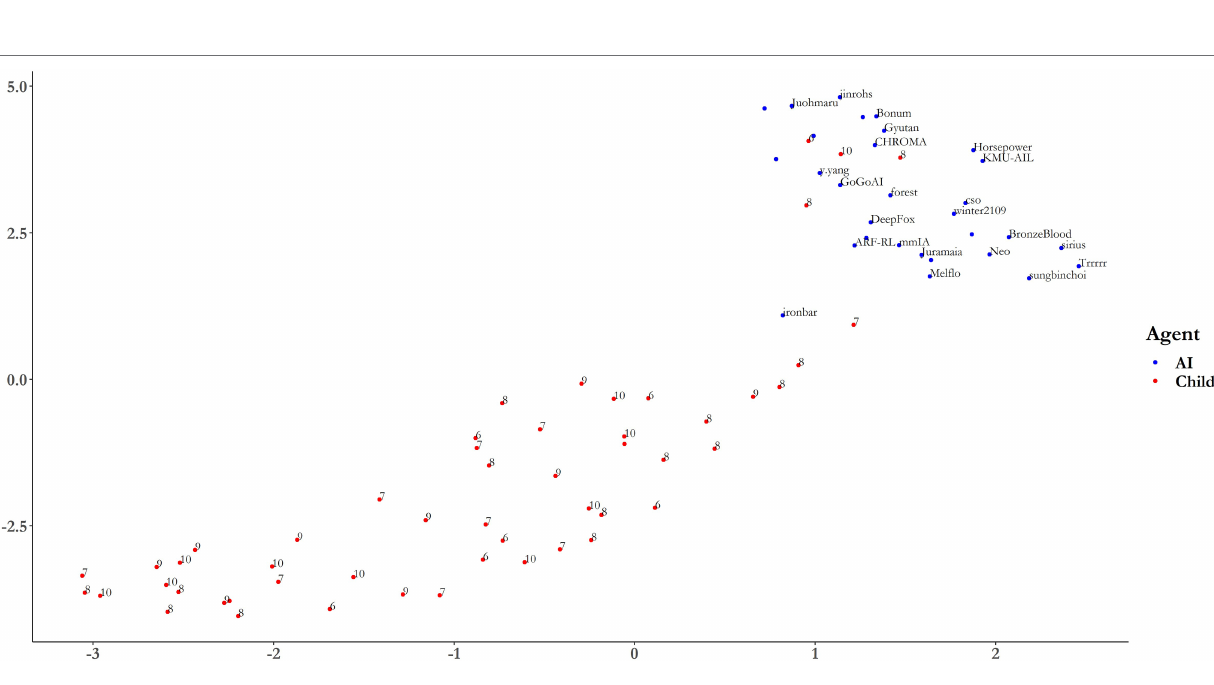
FIGURE 6 | UMAP projection onto 2-dimensions using default values of N = 15 and min-dist = 0.1. The labels for AIs correspond to the algorithm name. Age labels are included for children. See the RShinyDash app provided in the Supplementary Material for different parameter settings.